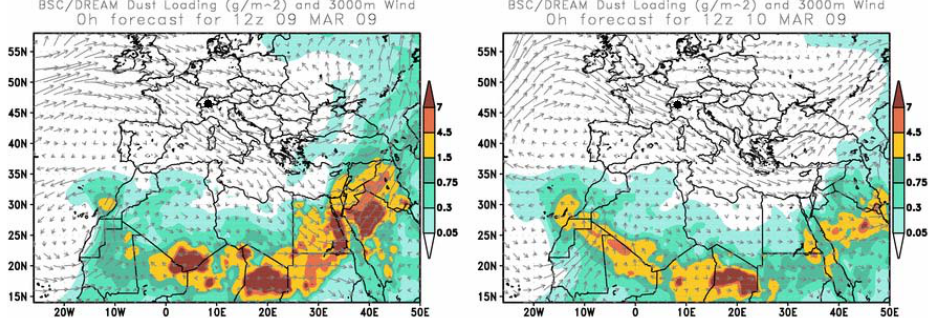
Fig. 5. Dust load distribution over the Mediterranean region on 9 and 10 March 2009 at 12:00p.m. UTC. The black dot marks the location of the Jungfraujoch.